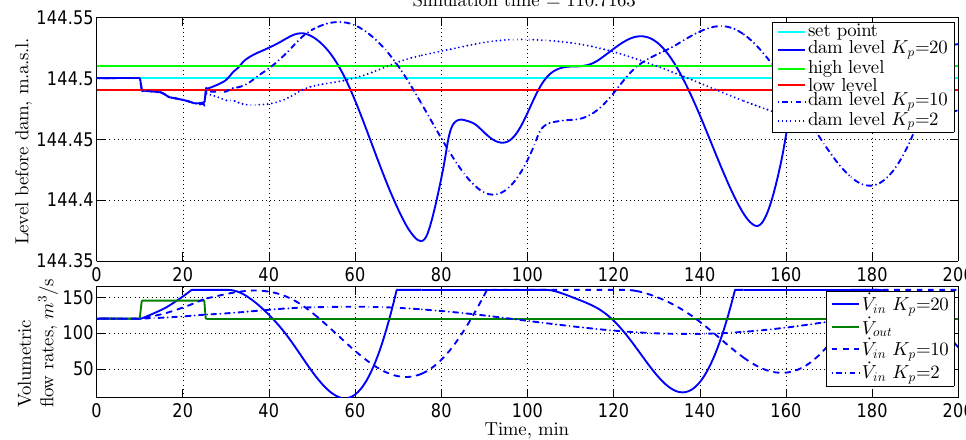
Figure 7: The results of simulation with P controller ( T s = 5 , K p = 20 , 10 and